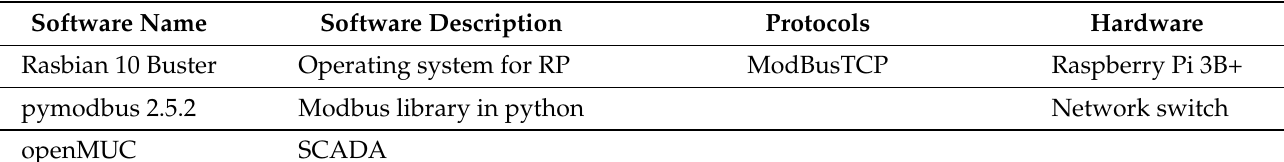
Table 7. Components of the simulated brewery